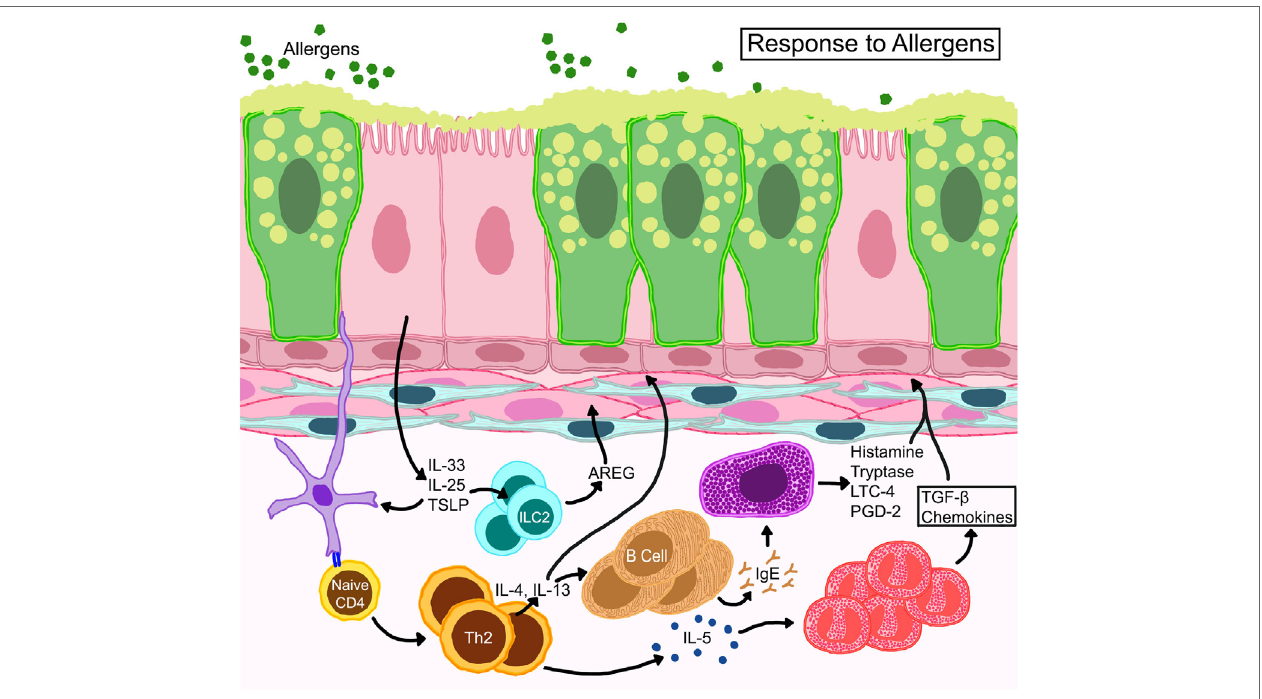
FiGURe 2 | Schematic representation of basic immune responses in asthma. Epithelial cells release thymic stromal lymphopoietin, IL-25, and IL-33 activating allergen-activated dendritic cells to present antigen via MHC-II to T cell receptors of naïve T cells which convert to Th2 cells through expression of GATA-3 transcription factor. IL-4 and IL-13 from T H 2 cells activate B cells for IgE synthesis. IL-13 also promotes goblet cell metaplasia and smooth muscle constriction. T H 2 cells also control eosinophil development and survival through IL-5. Resident mast cells may become activated directly through allergen-specific IgE or indirectly through other myeloid cells and release cytokines, such as histamine, tryptase, leukotriene C4 (LTC4), and prostaglandin D2 (PGD2). Eosinophils release multiple growth factors and fibrogenic mediators that regulate architectural changes in the airways. Resident innate lymphoid cells (ILC) become activated to release amphiregulin (AREG) that may promote wound-healing or repair